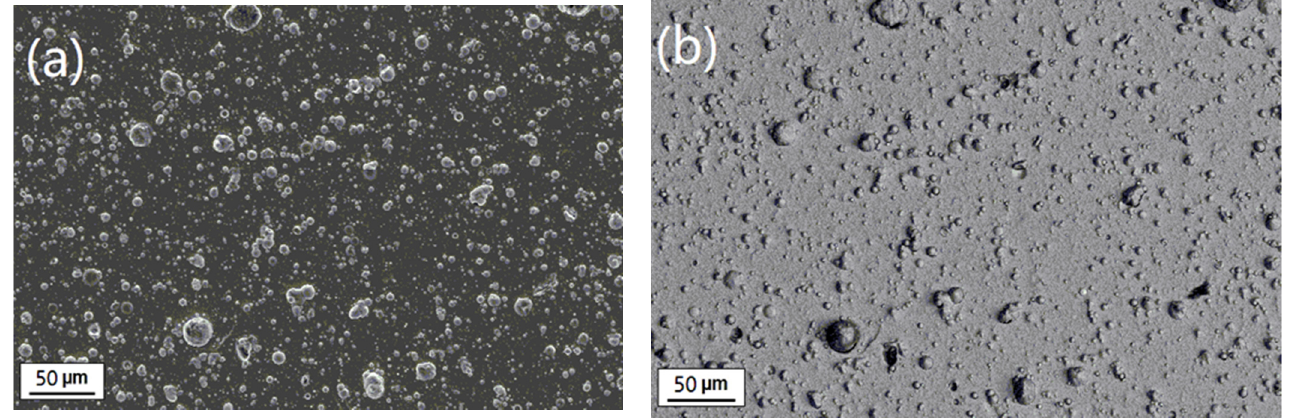
Figure 4. Surface micrographs of the ion-assisted arc deposition ZrN coatings: ( a ) SE and ( b ) BSE.